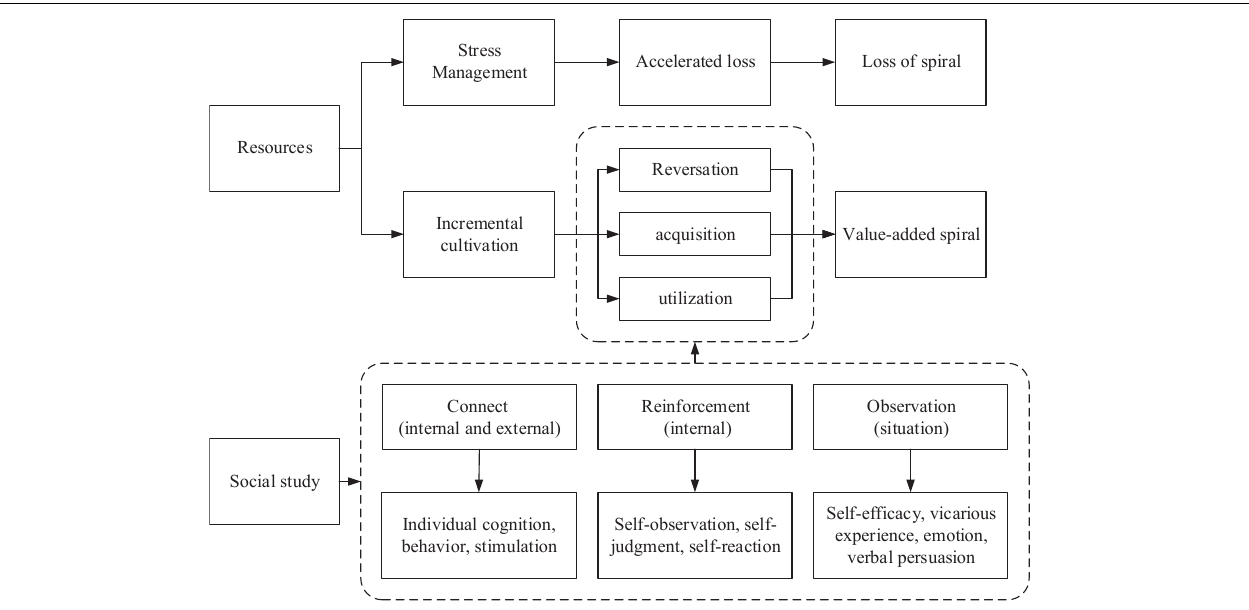
FIGURE 1 | Research theoretical